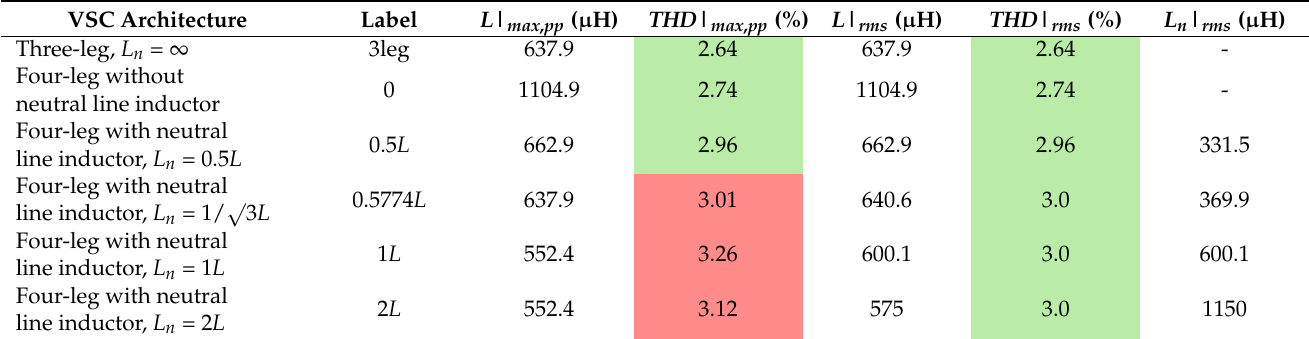
Table 4. Inductor design at the same switching